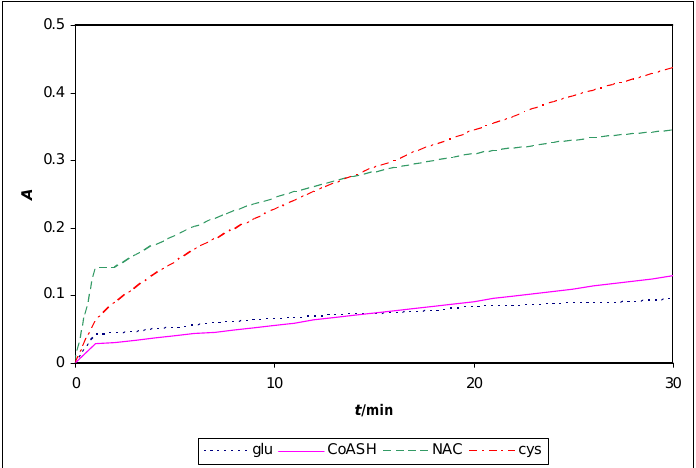
Figure 7. Absorbance change during reaction of thiols with Fe 3+ at 510 nm and